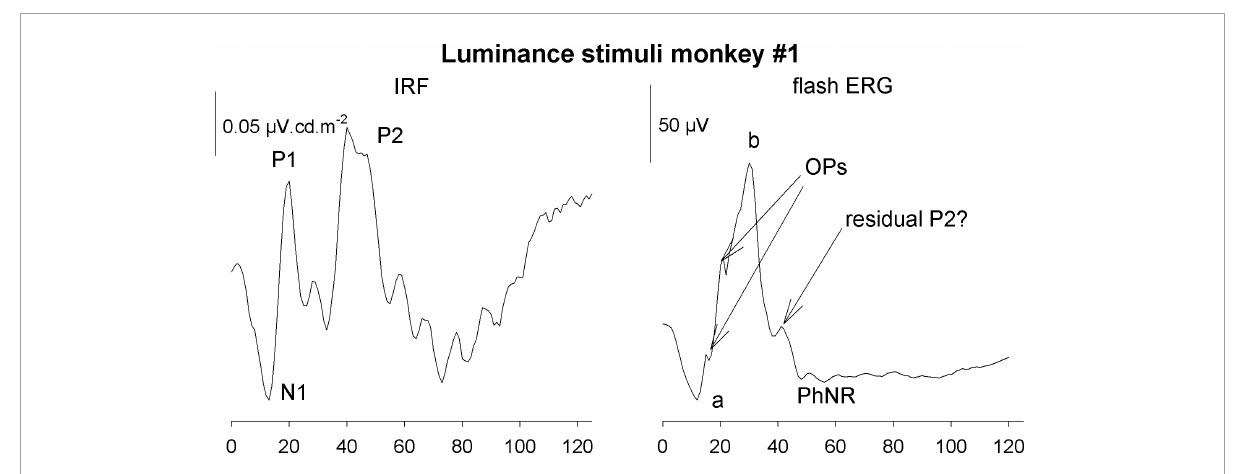
FIGURE14 Comparison of the luminance IRF from monkey #1 with the response to a 5.68 cd.s/m 2 flash upon a 38 cd/m 2 background.